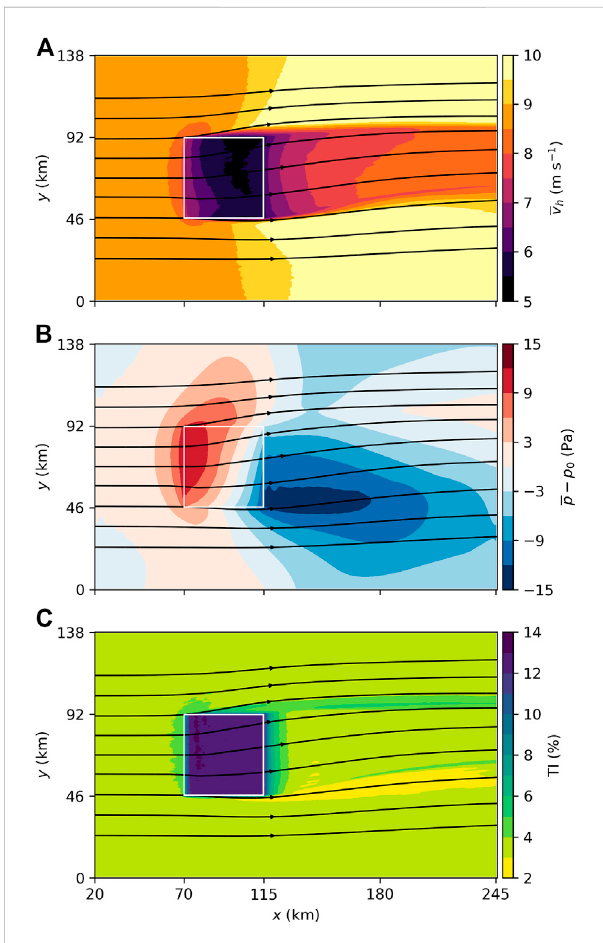
FIGURE 3 Horizontal cross sections of the mean horizontal wind speed (A) , the mean perturbation pressure (B) and the turbulence intensity (C) averaged over the last 4 h of the 24 h simulation time. An additional rolling average with a window size of one turbine spacing in x - and y -direction is applied to all quantities to facilitate the